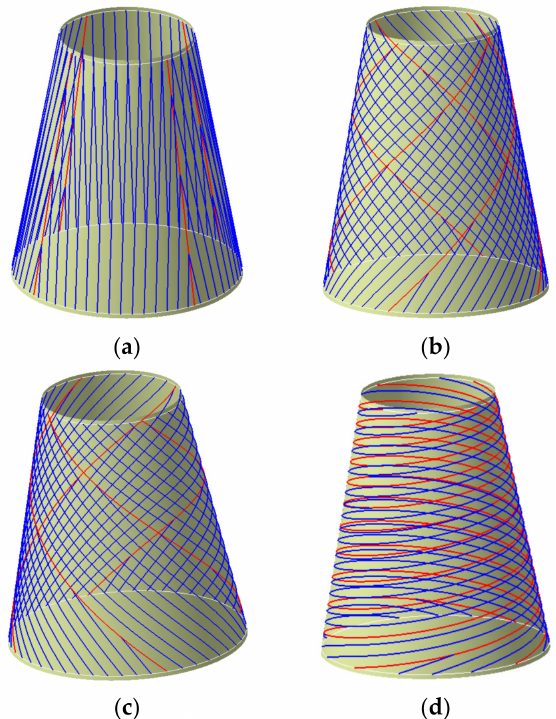
Figure 9. Four typical angle plies are based on partition. ( a ) 0 ◦ Ply. ( b ) 45 ◦ Ply. ( c ) − 45 ◦ Ply.